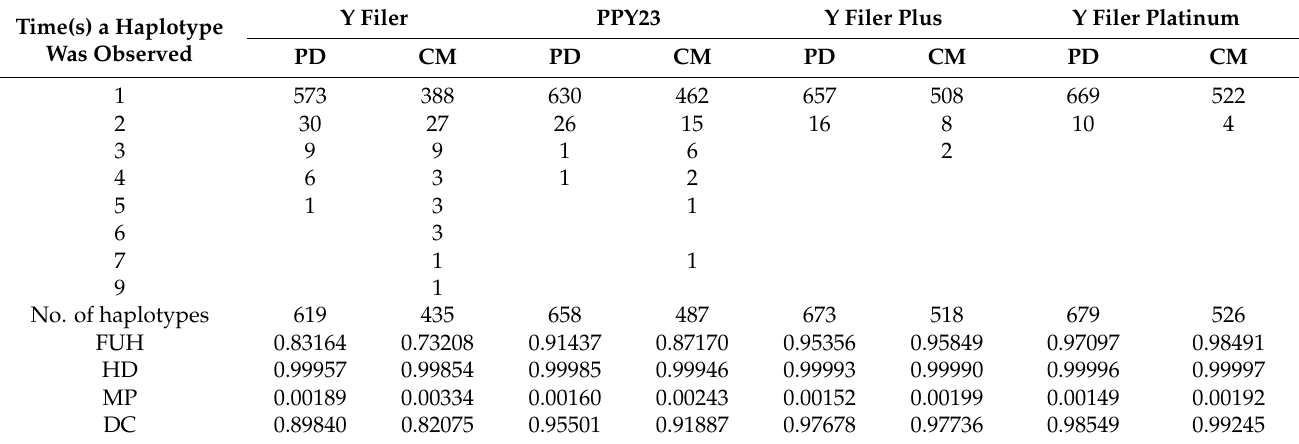
Table 1. Calculation of forensic parameters from 4 different Y-STR genotyping